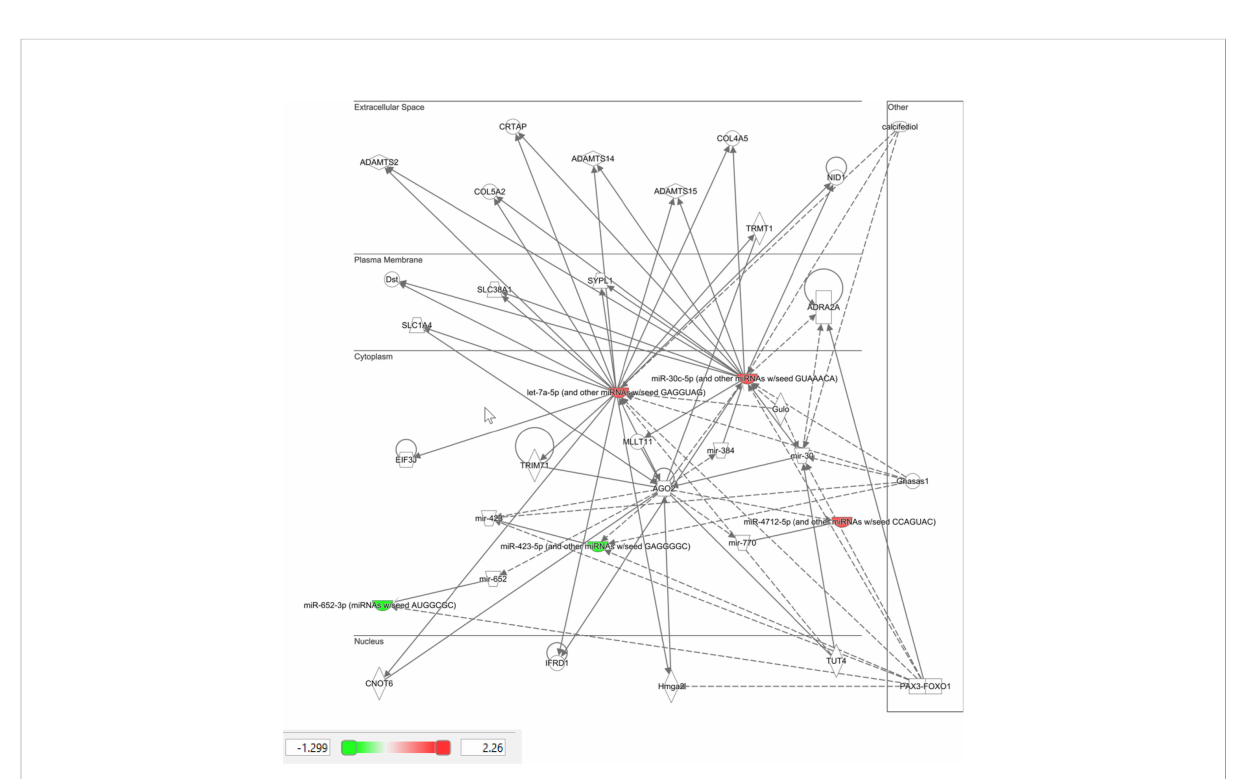
FIGURE 3 Ingenuity pathway analysis of top 10 miRNA that showed differential expression in control subjects in response to